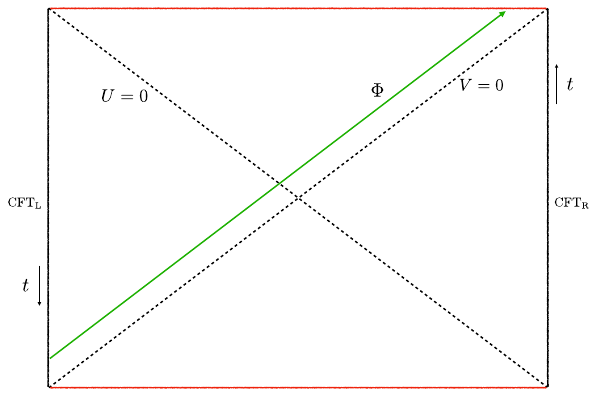
Fig. 19 Penrose diagram for the eternal Black Hole in AdS. The red horizontal lines represent the singularity. The green arrow represents a signal that originates at the left boundary and propagates towards the right